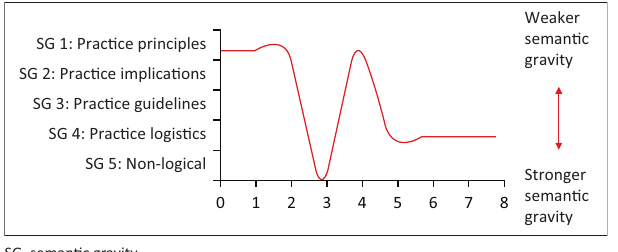
FIGURE 3: The semantic gravity profile of advice to teachers regarding